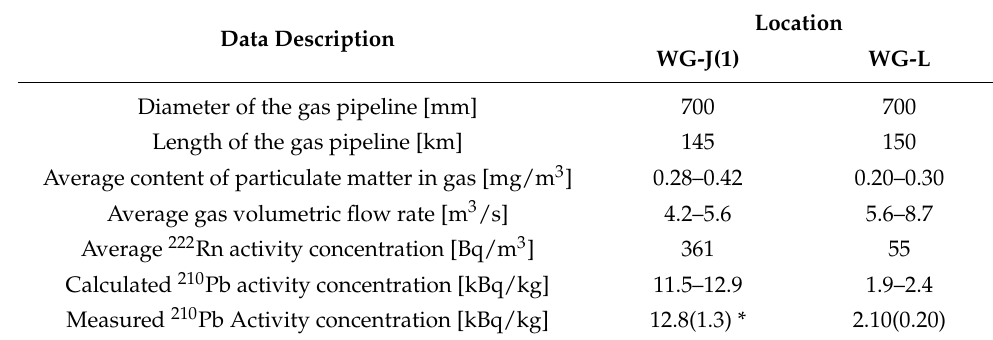
Table 5. The calculated and measured activity concentration of 210